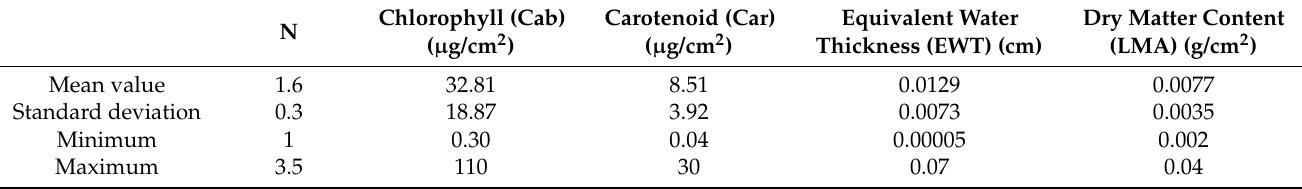
Table 1. Distribution characteristics of the leaf parameters for synthetic